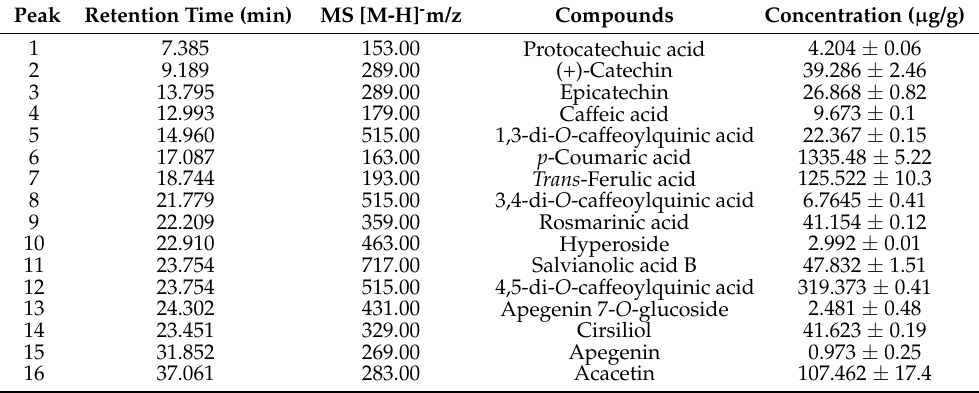
Table 4. HPLC–MS analysis of E. humile methanolic extract from aerial parts.